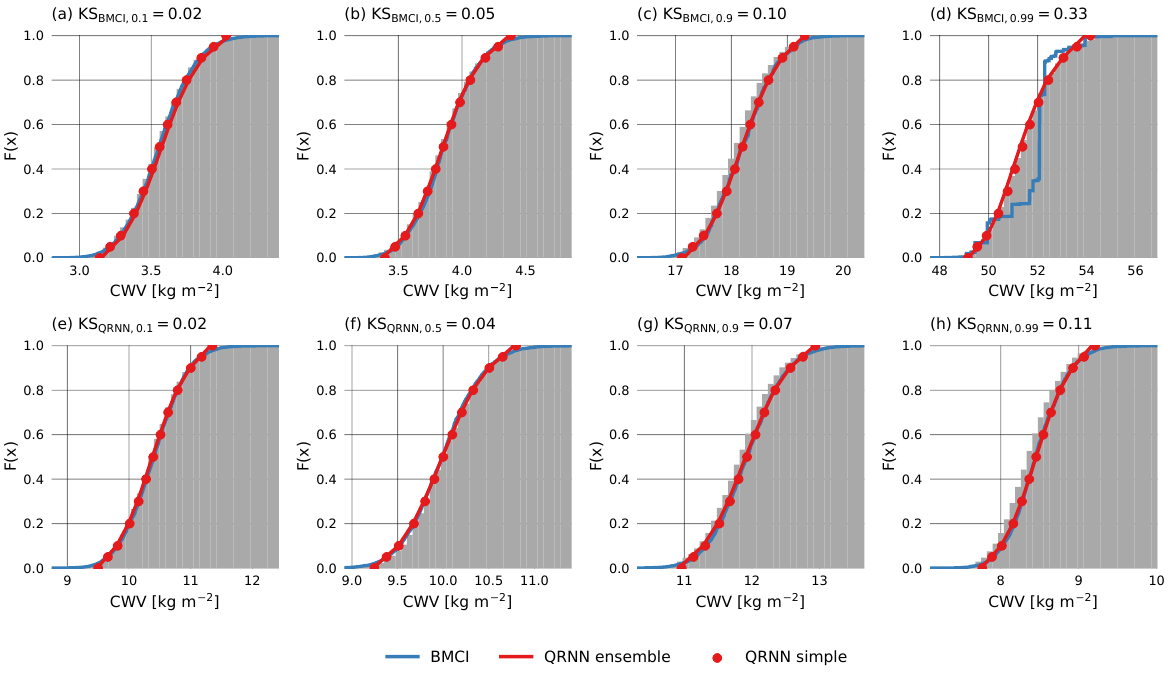
Figure 3. Retrieved a posteriori CDFs obtained using MCMC (gray), BMCI (blue), a single QRNN (red line) and an ensemble of QRNNs (red marker). Cases displayed in the first row correspond to the 1st, 50th, 90th and 99th percentiles of the distribution of the Kolmogorov– Smirnov statistic of BMCI compared to the MCMC reference. The second row displays the same percentiles of the distribution of the Kolmogorov–Smirnov statistic of the single-QRNN predictions compared to MCMC.